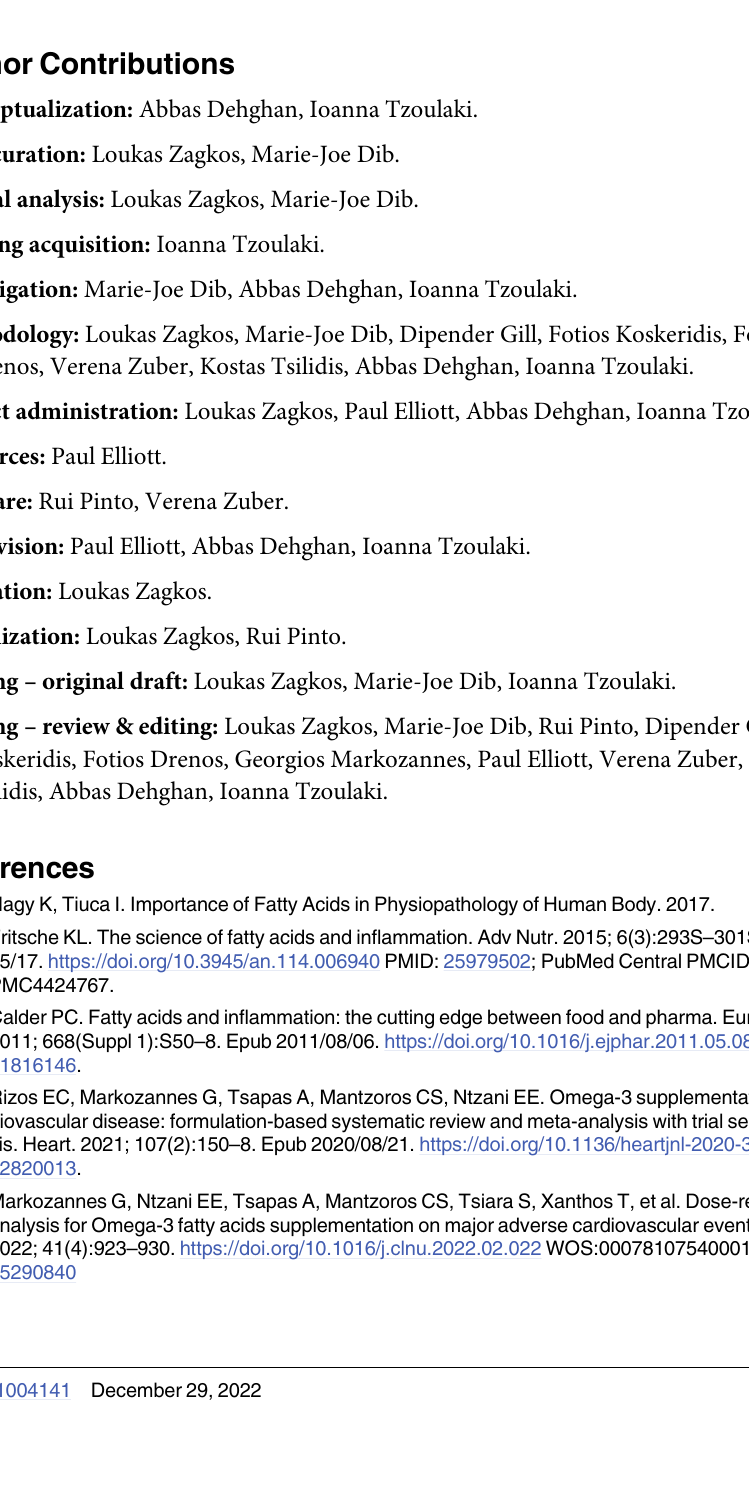
S7 Fig. PheWAS Manhattan plot. 845 clinical diagnoses were regressed against saturated fatty acids (SFA) genetic risk score (GRS). Age, sex, and the first 10 genetic principal components were used as covariates in the logistic regressions. S8 Fig. PheWAS Manhattan plot. 845 clinical diagnoses were regressed against total fatty acids genetic risk score (GRS). Age, sex, and the first 10 genetic principal components were used as covariates in the logistic